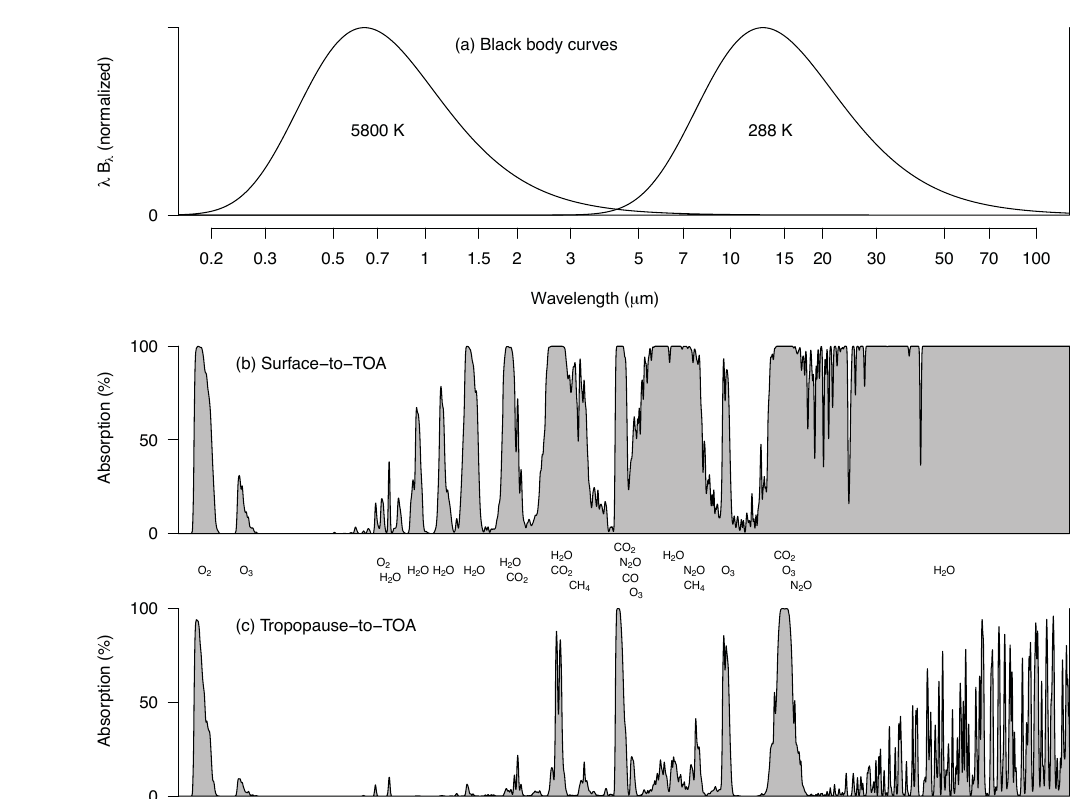
Figure 1. (a) Normalized black body curves for 5800K (the approximate emission temperature of the Sun) and 288K (the approximate surface temperature of the Earth). (b) Representative absorption spectrum of the Earth’s atmosphere for a vertical column from the surface to space, assuming the atmosphere to be a homogeneous slab. (c) The same but for a vertical column from the tropopause ( ∼ 11km) to space. Spectra based on HITRAN on the Web ; see Appendix D for details. Figure after Goody and Yung (1989, Fig. 1.1 on p.